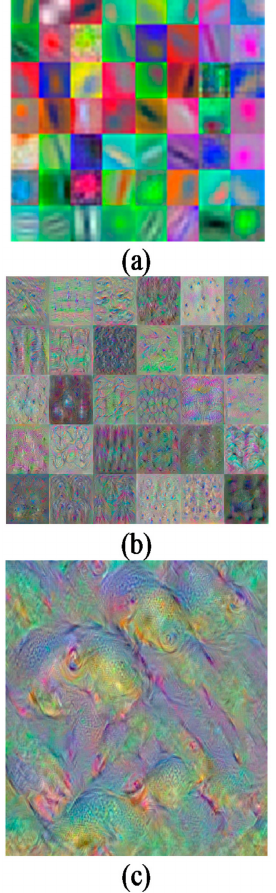
Figure 7. Sample of features extraction. ( a ) Conv1 (56 channels); ( b ) Conv5 (30 channels); and ( c ) FC8 layer (channel